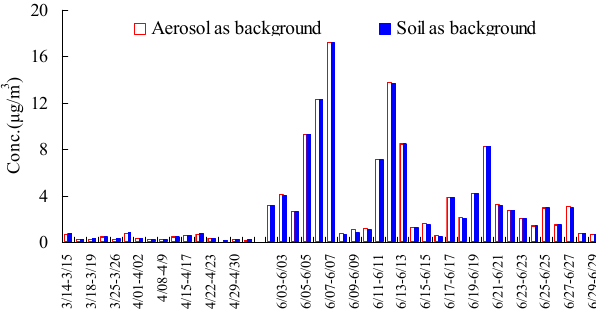
Fig. 5. Daily variations of K + , Na + , and Al in PM 2.5 from 14 March to 30 June in 2006 at MT.